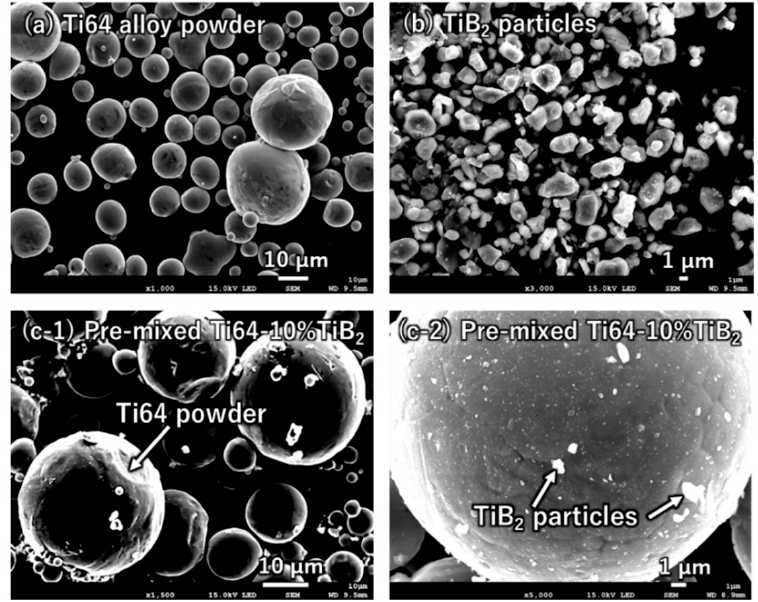
Figure 1. SEM images of the ( a ) TiBw-reinforced Ti-6%Al-4%V (Ti64) alloy powder, ( b ) TiB 2 particles, and ( c ) Ti64-10%TiB 2 elemental mixture used in this study ( c-1 : 10 um; c-2 : 1 um).